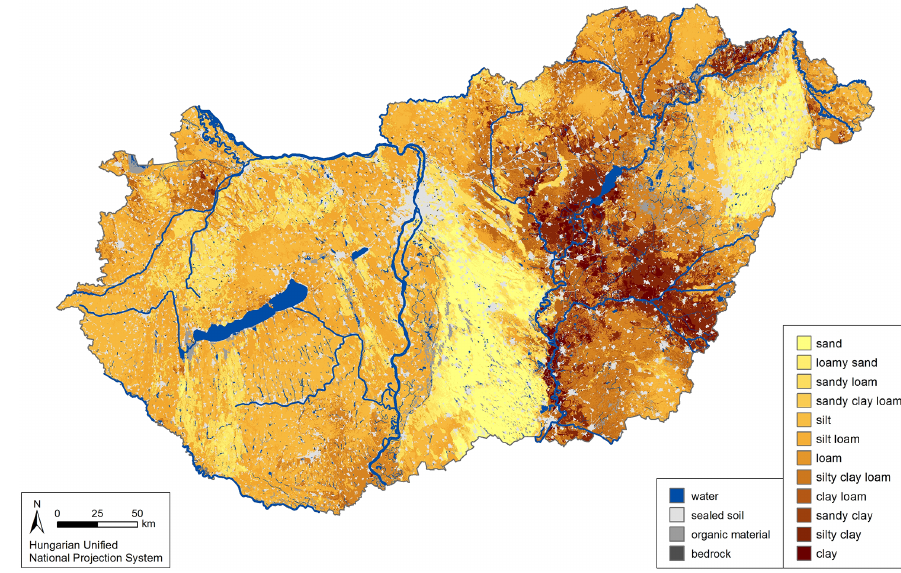
Figure 5. Hungary’s soil texture map of the uppermost layer (0–5cm) according to USDA categorisation.